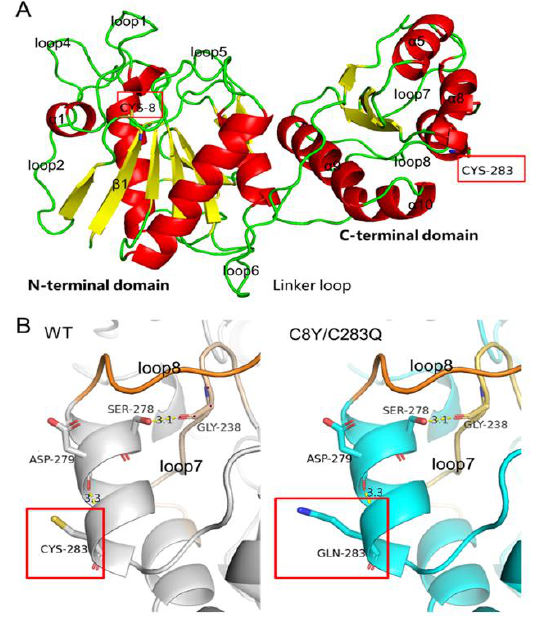
Figure 5. Alteration in the model structures of AsA and mutant C8Y/C283Q. ( A ) Location of Cys8 and Cys283 on AsA monomer. ( B ) Structure comparison around residue Cys283 of the wild-type and the mutated residue (Gln283) of mutant C8Y/C283Q.